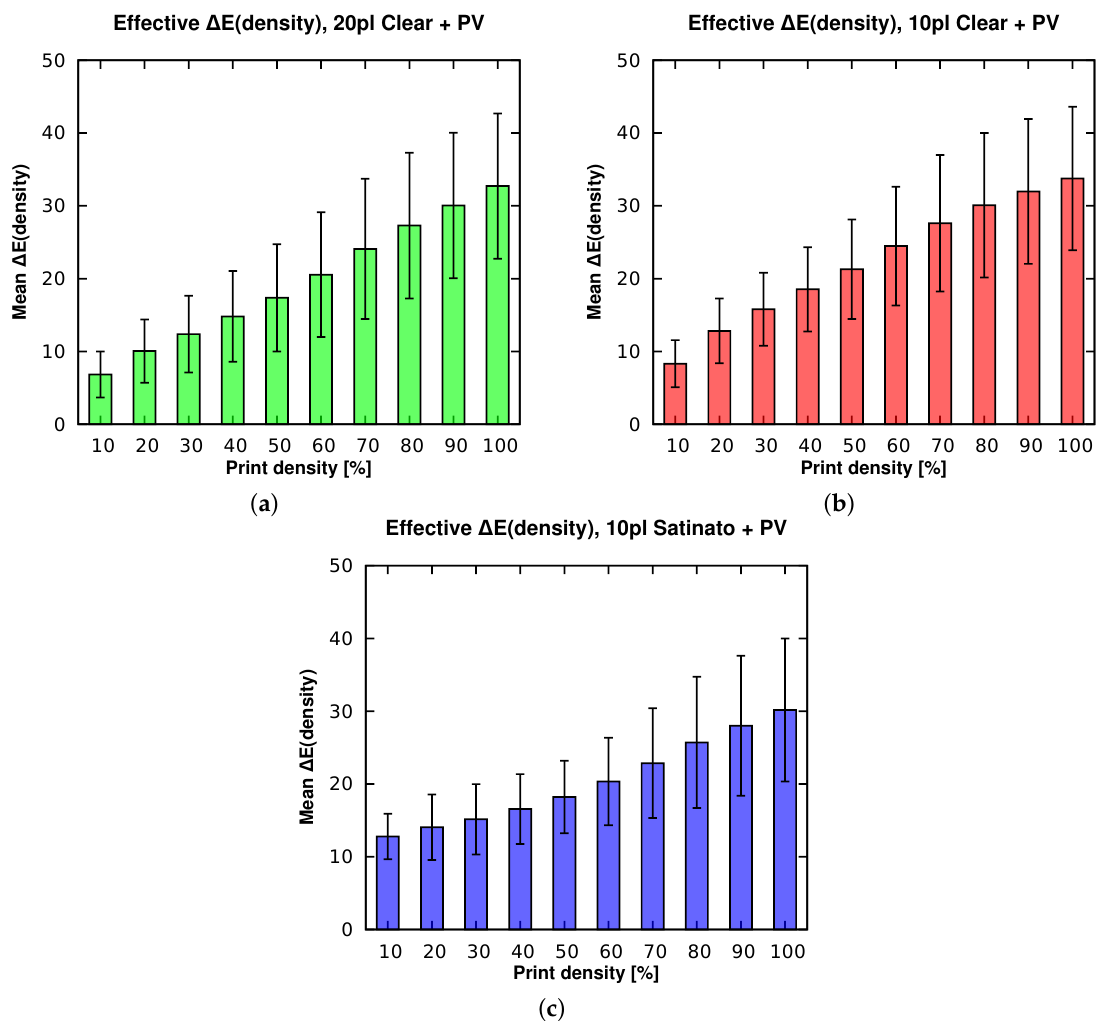
Figure 8. Mean and standard deviation of colour difference ∆ E between effective printed and nominal colours as a function of print density for 20 pl ( a ) and 10 pl ( b ) on clear glass, and 10 pl on satinated glass ( c